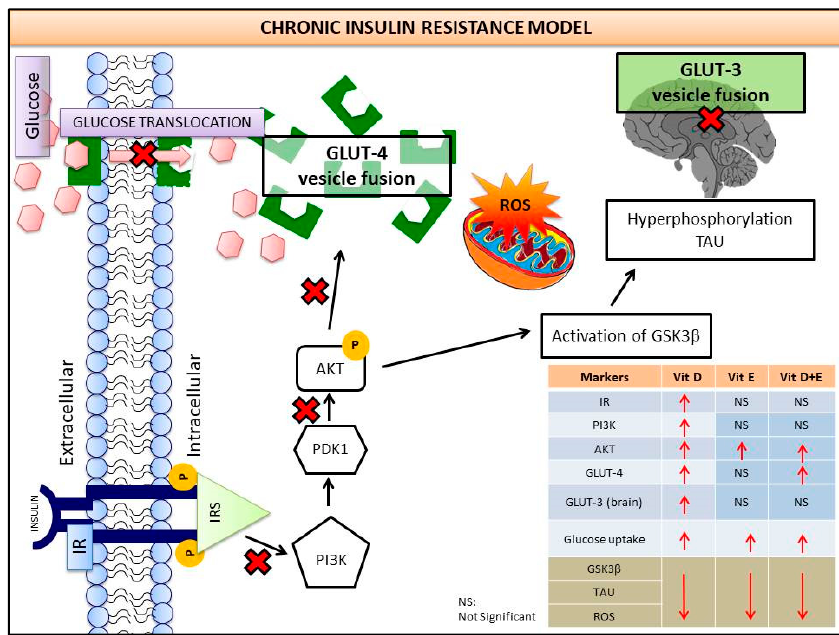
Figure 10. Continuous impaired insulin signalling causes the activation of AD markers ( GSK3 β and TAU genes), thus increasing the amyloid beta aggregations leading to AD. Current study reports the role of vitamin D, E and the combinations of vitamins D and E in restoring insulin signalling to normal physiological condition by downregulating GSK3 β and TAU genes, eventually reducing the risk of AD. Decreased AKT phosphorylation inhibits the insulin-stimulated glucose transporter GLUT4